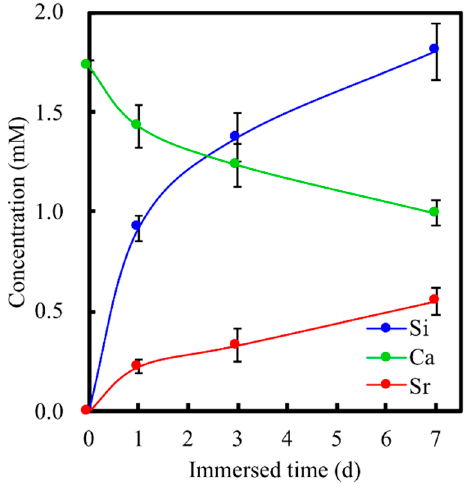
Figure 2. ( A ) SEM images of the surfaces of SrCS scaffolds and ( B ) X-ray diffraction patterns of SrCS scaffold after immersed in simulated body fluid (SBF).